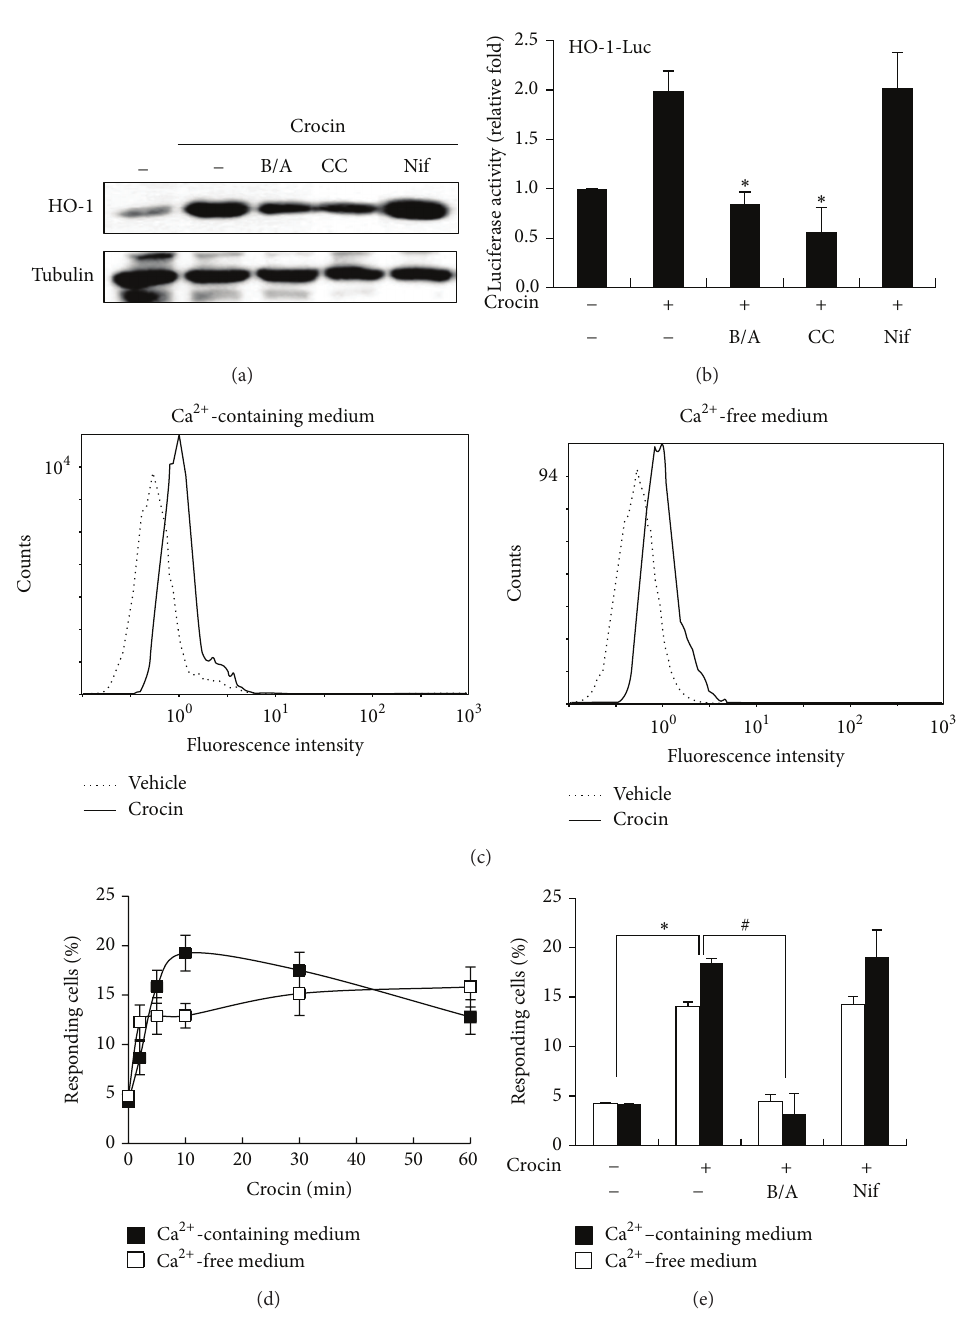
Figure 5: Induction of HO-1 expression via elevation of intracellular Ca 2+ levels. (a) RAW 264.7 cells were incubated with BAPTA/AM (B/A, 5 𝜇 M), calmidazolium chloride (CC, 5 𝜇 M), and nifedipine (Nif, 5 𝜇 M) for 1h and then treated with crocin (500 𝜇 M) for 6h. Equal amounts of cytosolic proteins were subsequently analyzed by Western blotting with HO-1 antibody. Tubulin was used as a loading control. (b) Cells were transfected with HO-1 promoter-luciferase construct and then treated as described above, after which equal amounts of cell extracts were assayed for dual luciferase activity. ∗ 𝑃 < 0.05 versus the group treated with crocin alone. (c) Intracellular free Ca 2+ levels were assessed by flow cytometry. Cells were treated with vehicle or crocin (500 𝜇 M) for 10min in either Ca 2+ -containing medium (left) or Ca 2+ -free medium (right). (d) The changes of intracellular Ca 2+ levels with time were represented as percentages of responding cells. (e) Cells were treated with crocin (500 𝜇 M) in the absence or presence of BAPTA/AM (B/A, 5 𝜇 M), or nifedipine (Nif, 5 𝜇 M) for 10min, after which intracellular free Ca 2+ levels (represented as percentage of responding cells) were evaluated by flow cytometry. ∗ 𝑃 < 0.05 versus the group treated with PBS (vehicle); # 𝑃 < 0.05 versus the group treated with crocin alone in both Ca 2+ -containing and Ca 2+ -free